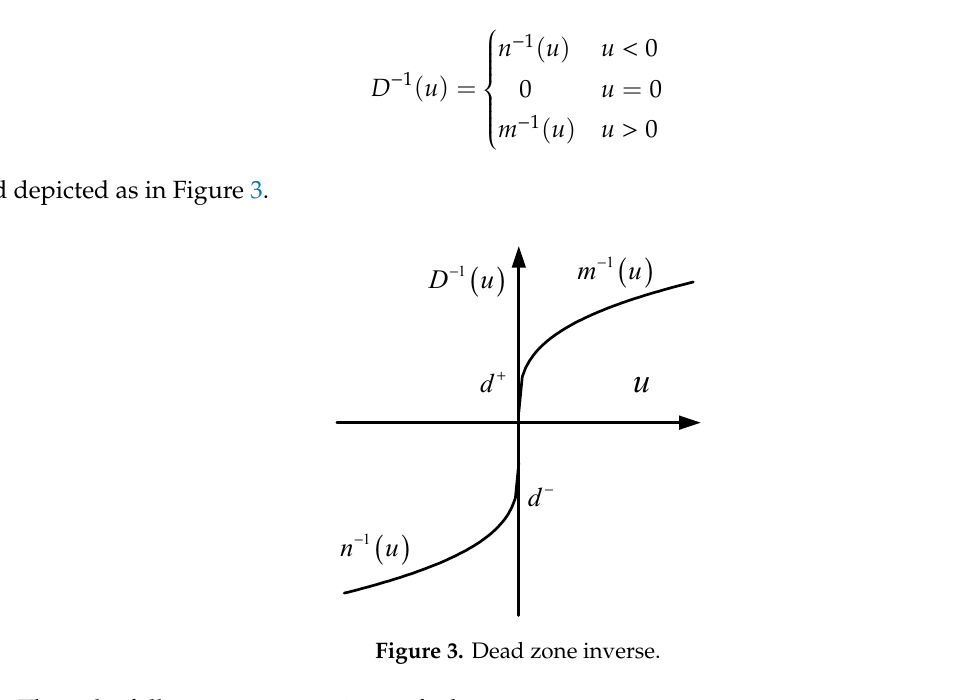
Figure 3. Dead zone inverse.